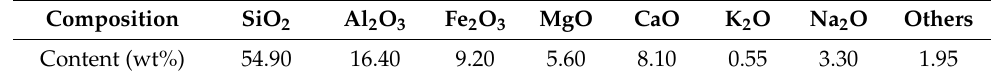
Table 1. Chemical composition of basalt glass.